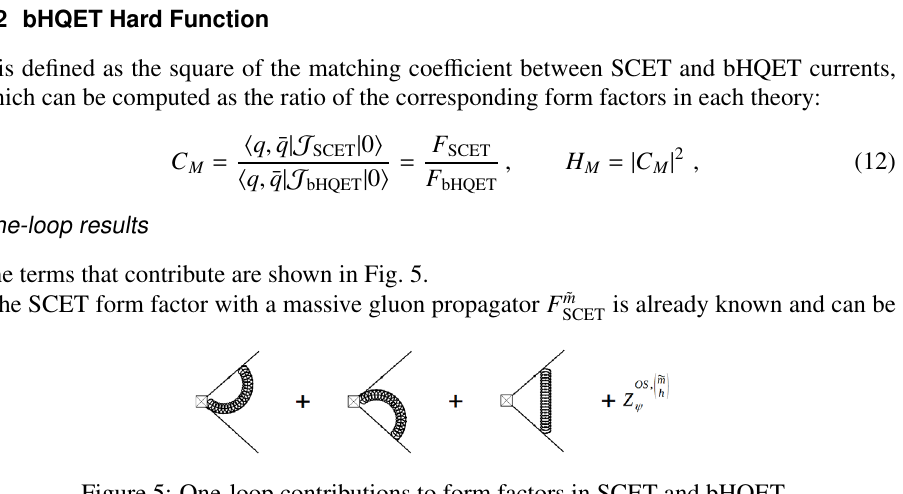
Figure 5: One-loop contributions to form factors in SCET and